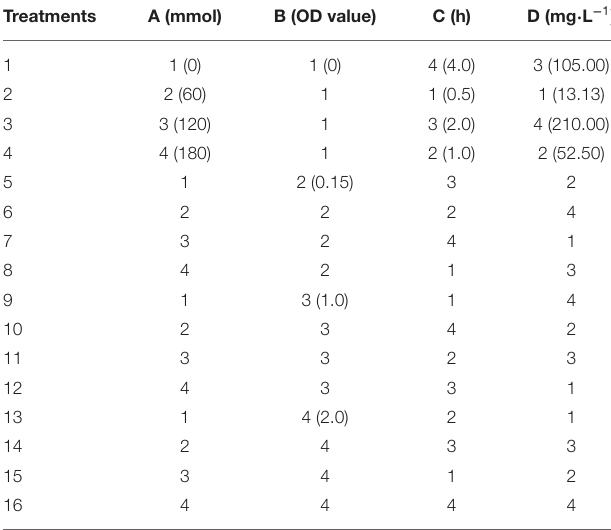
TABLE 1 | Assignments of the orthogonal matrix L 16 (4 5 ).